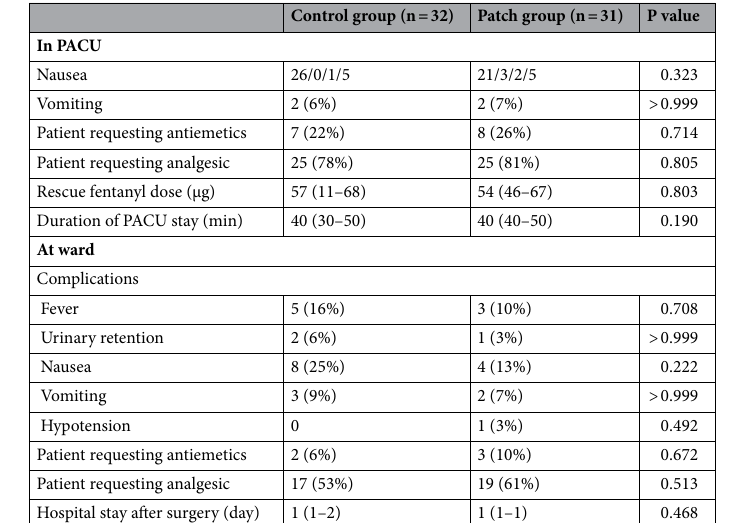
Table 3. Recovery profiles. Values are presented as median (interquartile range) or number (%). PACU post- anesthesia care unit.